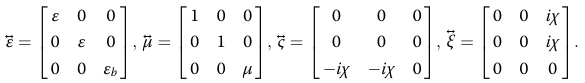
ðþ 1 ; þ 1 Þ to ð(cid:2) 1 ; (cid:2) 1 Þ on the intersection line of the two = k = 0). For a two-band model with mirror planes ( k y z PT symmetry, the eigenfunctions are purely real, so that a loop encircling the chain point (or a general point on the nodal line) carries a Z -valued charge, i.e., integer charges